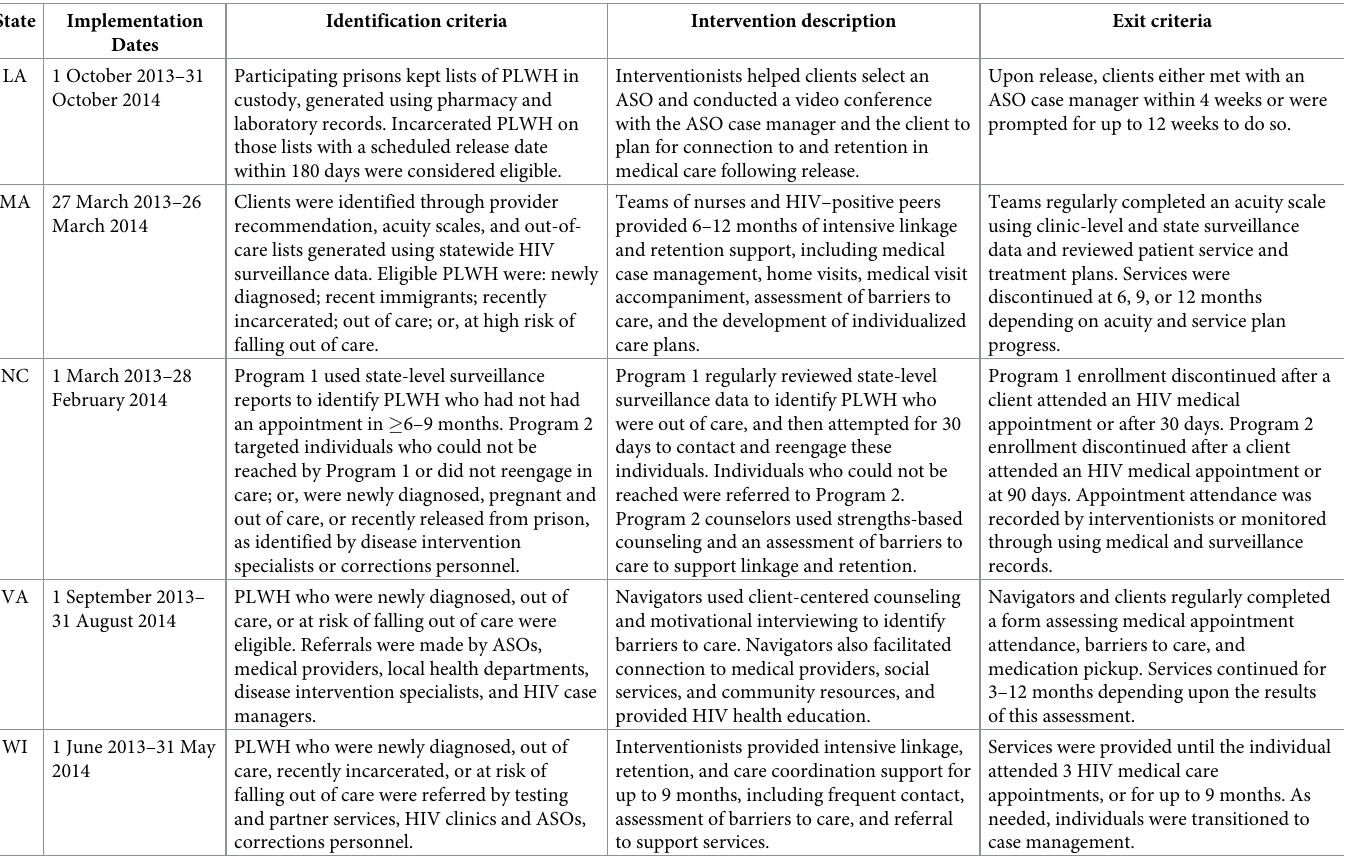
Table 1. Descriptions of 5 navigator-like interventions selected for cost